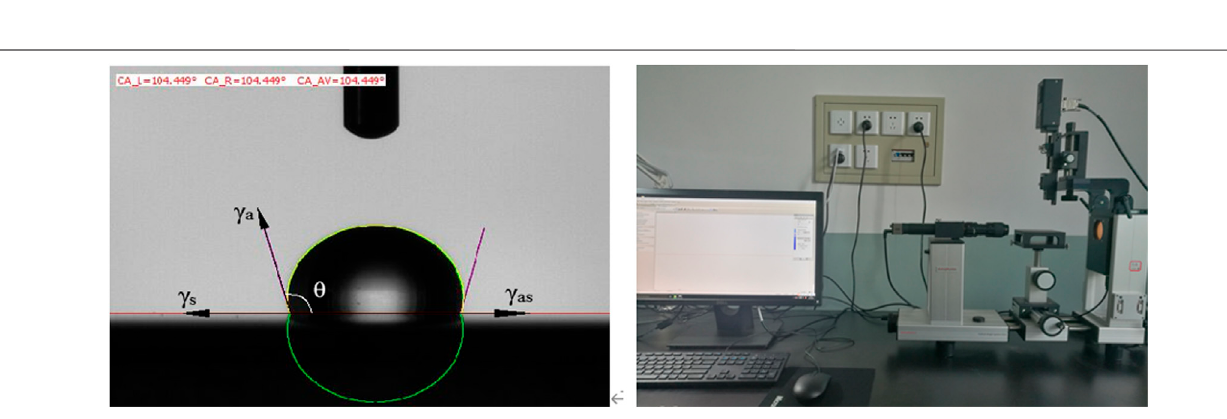
Frontiers in Materials |